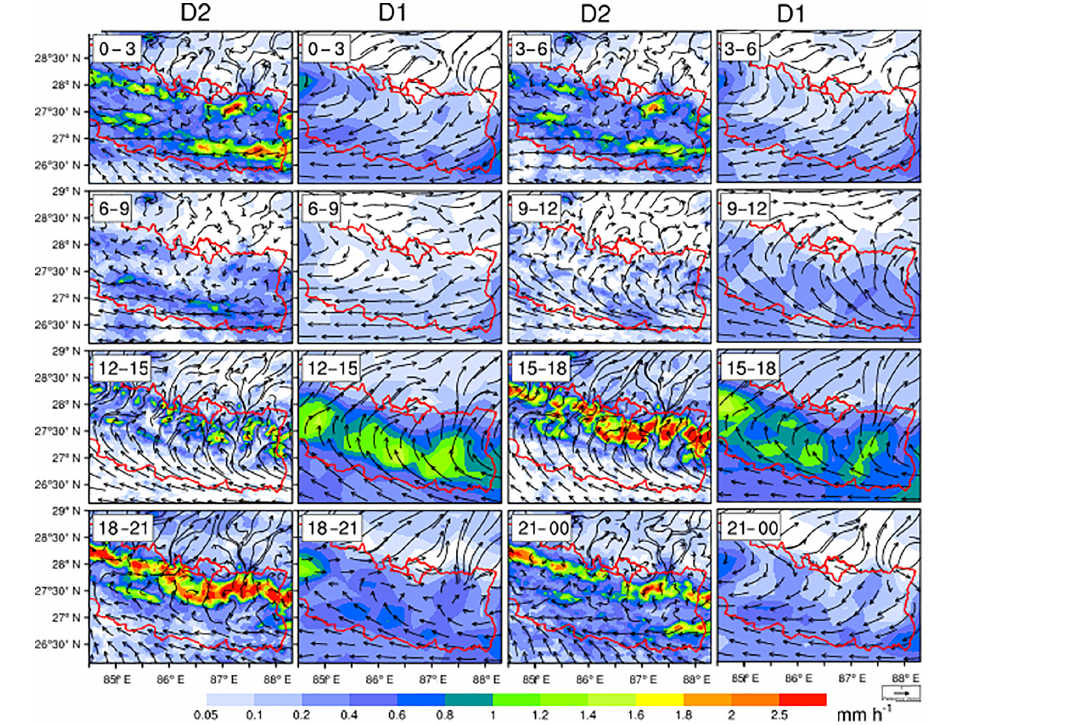
Figure 18. Spatial distribution of monsoon season three-hourly (local time) average precipitation (mmh − 1 ) in a large area of D2 and D1 with surface wind (10m) vectors overlaid; the political boundary of Nepal is given in red, with the Khumbu and Rolwaling catchments in the